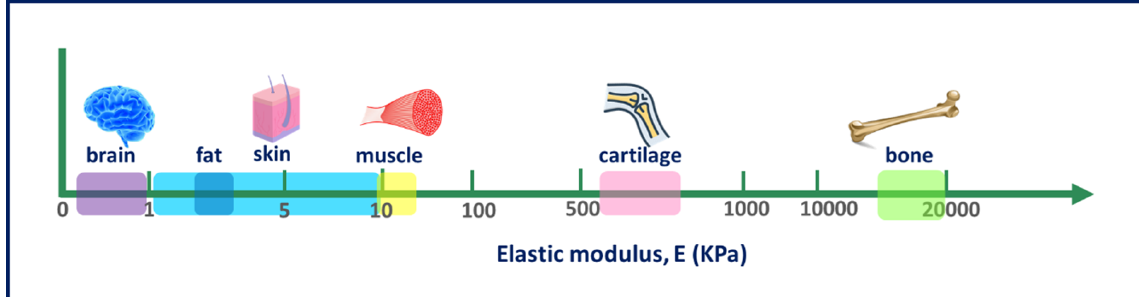
Figure 6. Schematic depicting the normal variation in elasticity of the indicated tissue.